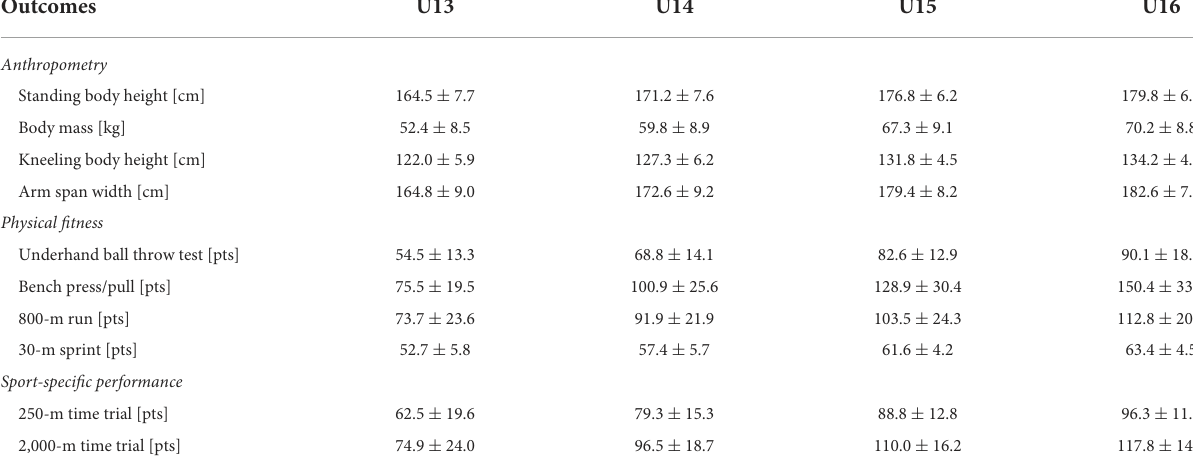
TABLE 3 Anthropometric, physical fitness and sport-specific performances measures in young male canoeists.